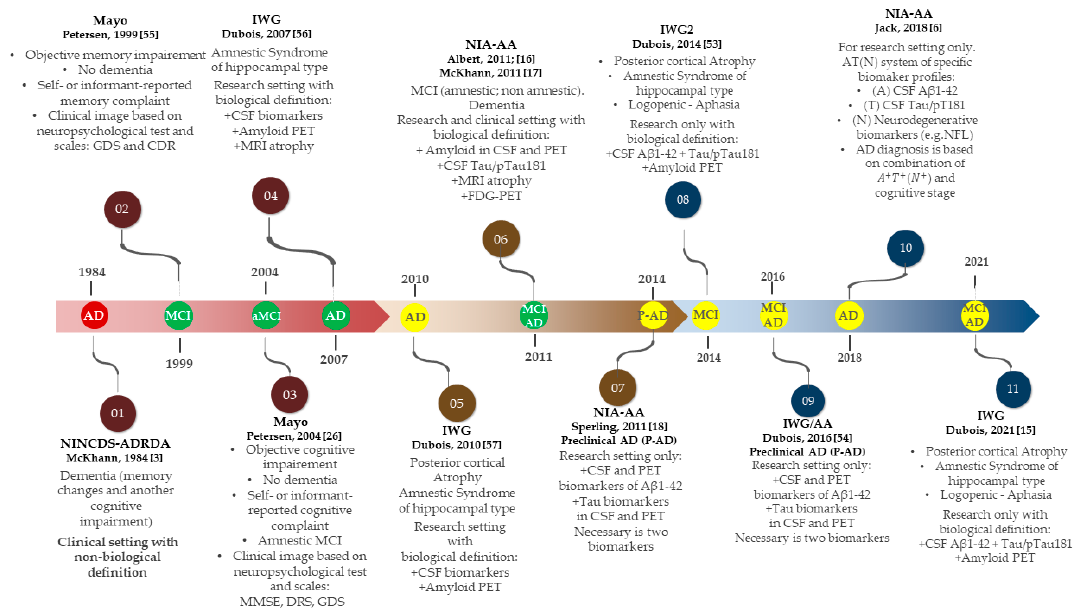
Figure 1. Evolution of diagnostic frameworks for Alzheimer’s disease [3,6,15–18,26,53–57]. Colors: Red—Diagnostic criteria that are no longer commonly used; Green—Widely accepted and used clinically and/or in research; Yellow—Used primarily in research and recommended for research use only. Abbreviations: GDS—Global Deterioration Scale, CDR—Clinical Dementia Rating Scale, DRS—Dementia Rating Scales; MMSE—Mini-mental state examination; PET—Positron emission tomography;